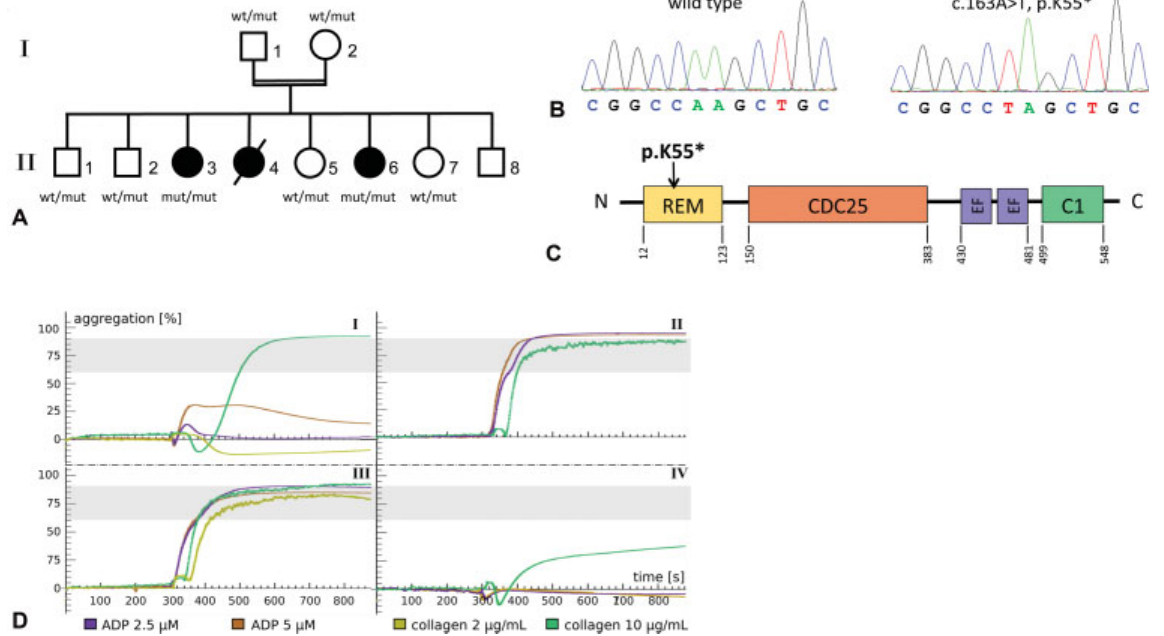
Fig. 1 Genetic and functional fi ndings. ( A ) Pedigree of family with clinically affected individuals colored in black. ( B ) Electropherograms of wild type and mutant sequences depicting the homozygous RASGRP 2 mutation. ( C ) Protein structure of RasGRP2 and location of the here described mutation. ( D ) Aggregometric analysis of (I) patient 1 exemplary for a homozygous RASGRP2 mutant phenotype, (II) a heterozygous carrier, (III) a normal control, and (IV) a patient with Glanzmann ’ s thrombasthenia. In individuals affected by a homozygous RASGRP2 mutation, platelet aggregation is impaired by standard concentrations of the inductors ADP and collagen but is normal at a markedly elevated collagen concentrationof 10 µg/mL. The reference range of maximum aggregationforbothconcentrationsofcollagenandADP isbetween60and90%, as indicated by the area colored in gray. ADP, adenosine diphosphate; wt, wild type; mut,